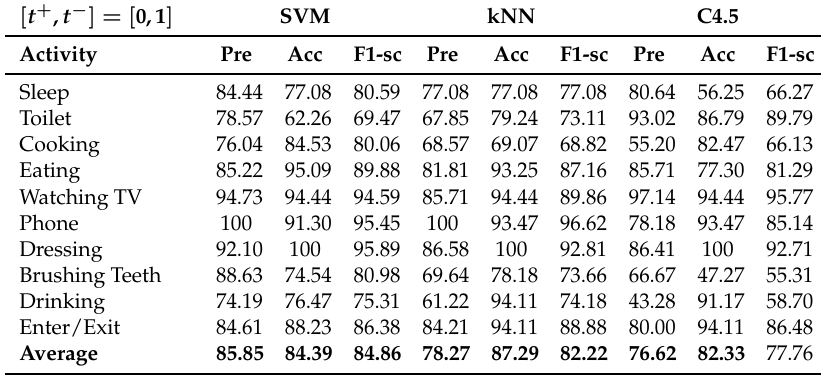
Table 6. Results with extended baseline features: precision (Pre), recall (Rec) and F1-score